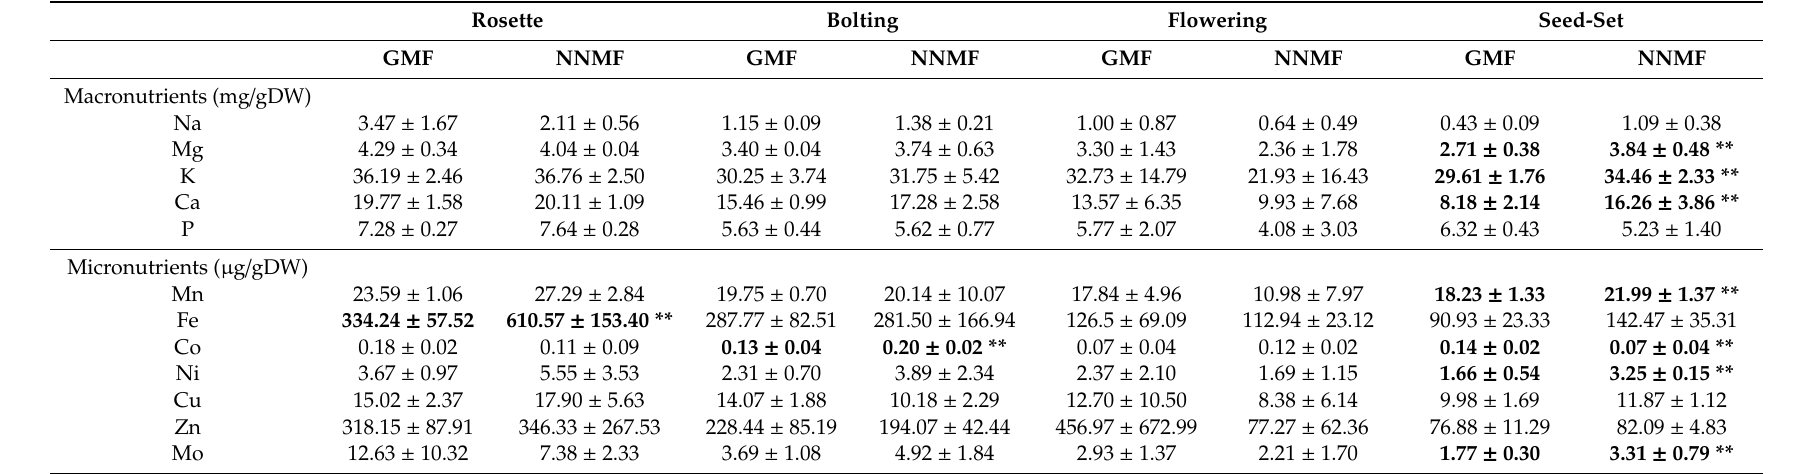
Table 1. Macro and micronutrients contents in di ff erent developmental stages from rosette to seed-set of Arabidopsis exposed to GMF (control) and NNMF. Data are expressed as mean value ( ± standard deviation) from three independent biological replications. ** Boldfaced figures indicate significant ( p < 0.05) di ff erence between GMF and